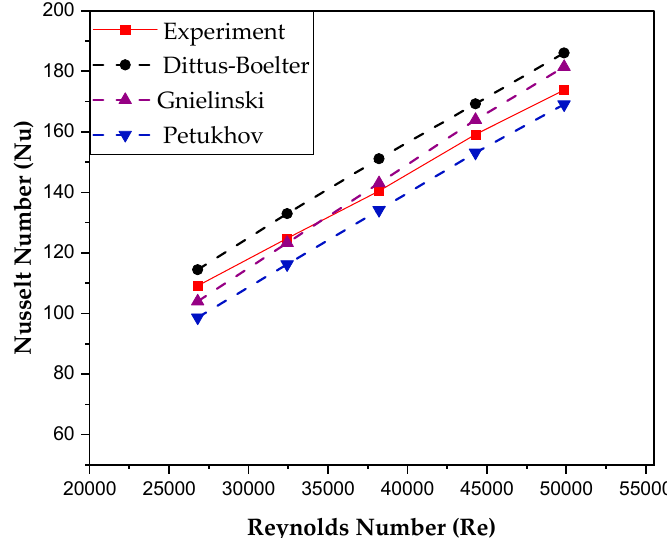
Figure 5. Setup validation.